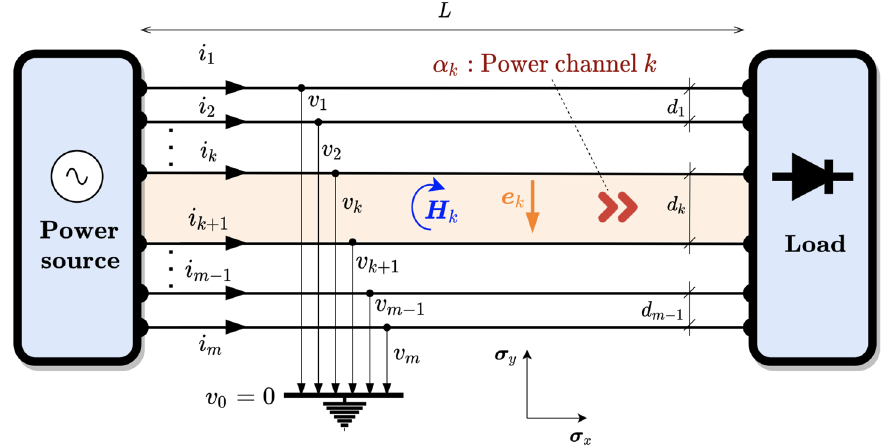
Figure 2. Generic multi-phase circuit with m wires. The power flows through every power channel α k delimited by wires k and k + 1